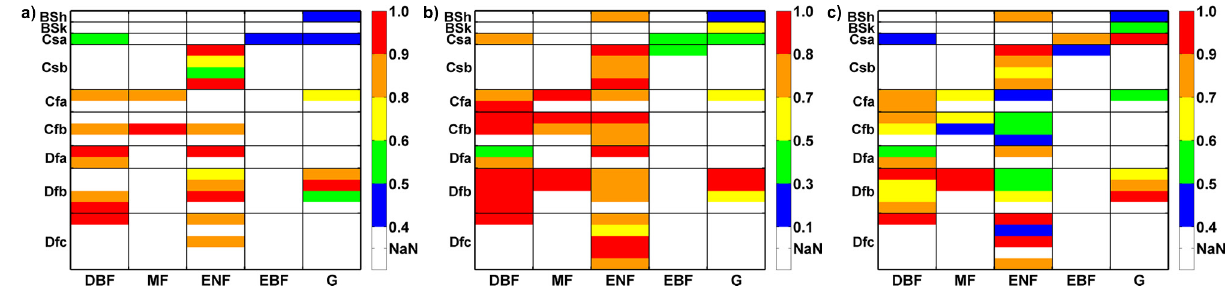
Fig. 11. Model parameter p with respect to vegetation and climate classes for the model runs with SWC (a) , API (b) , and VPD (c) as input variables. See Fig. 3 for an explanation of the